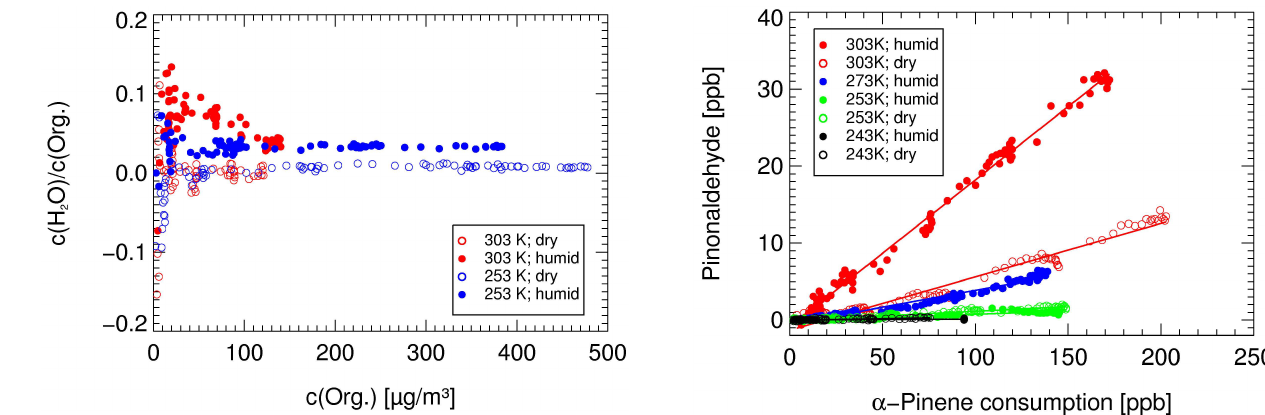
Fig. 5. Pinonaldehyde mixing ratios measured in the gas phase vs. the consumed α -pinene for the temperature (colour coded lines and points) and humidity regimes (open symbols: dry and filled sym- bols: humid conditions). The data points present standard measure- ments with particle filter in-line and OH scavenger as described in the experimental